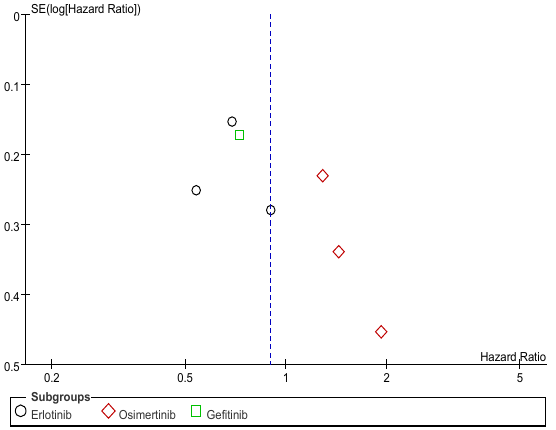
Figure A6. PFS comparisons among never smoker stratified by regimen.